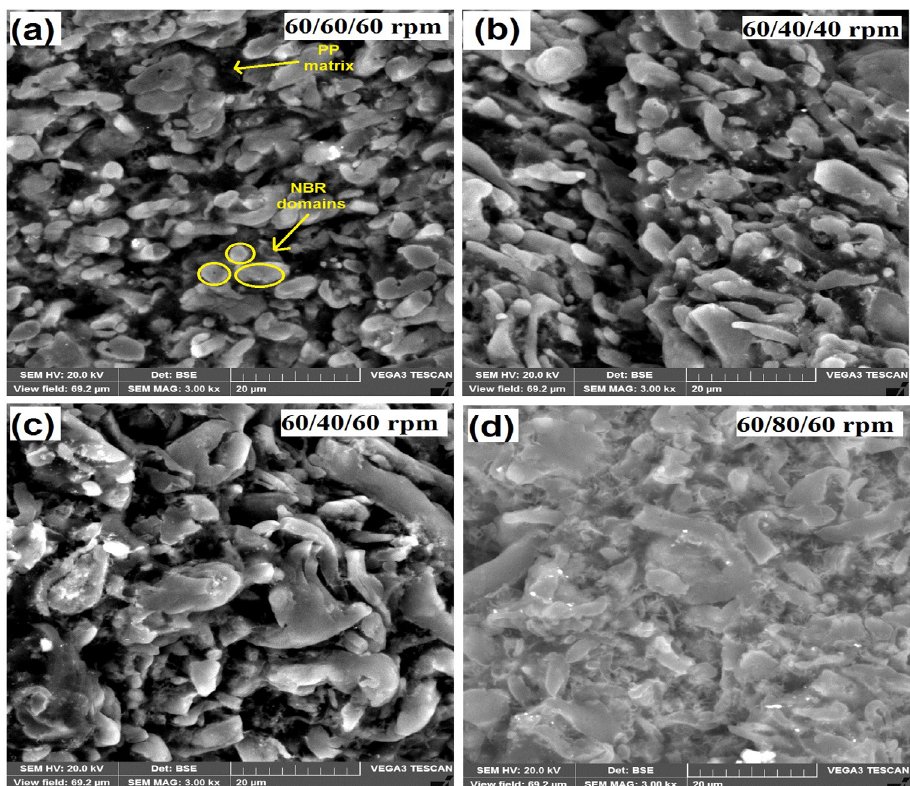
Figure 7. SEM micrographs of PP/NBR 30/70 mixed using speed profile V1 (a), V2 (b), V3(c) and V4